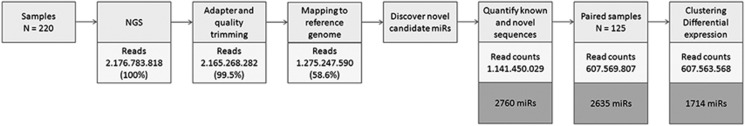
Overview of the number of raw reads, the number of reads after adapter and quality trimming, and the number of reads of at least 18 nt, which could be mapped with a maximum of two mismatches to the reference genome (browser hg 19). 2760 miRs were represented by 1 141 450 029 read counts, of which 2635 miRs were detected in at least 1 of the 125 samples used for paired sample analysis and 1714 miRs were detected in at least 3 of the 125 samples.